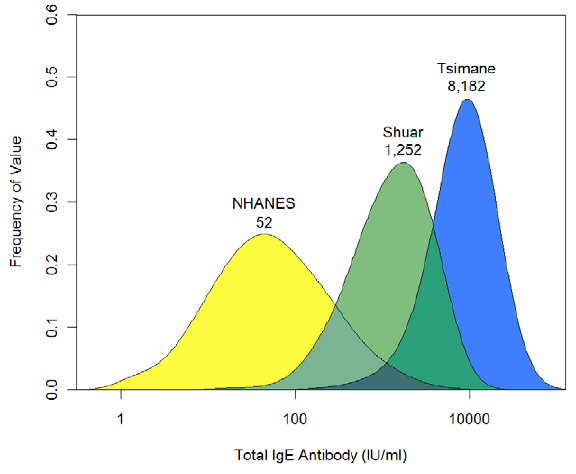
Figure 1. Distribution and geometric mean value of IgE antibody levels in three populations. Density plots were generated with a Gaussian smooth with bandwidth 0.5.